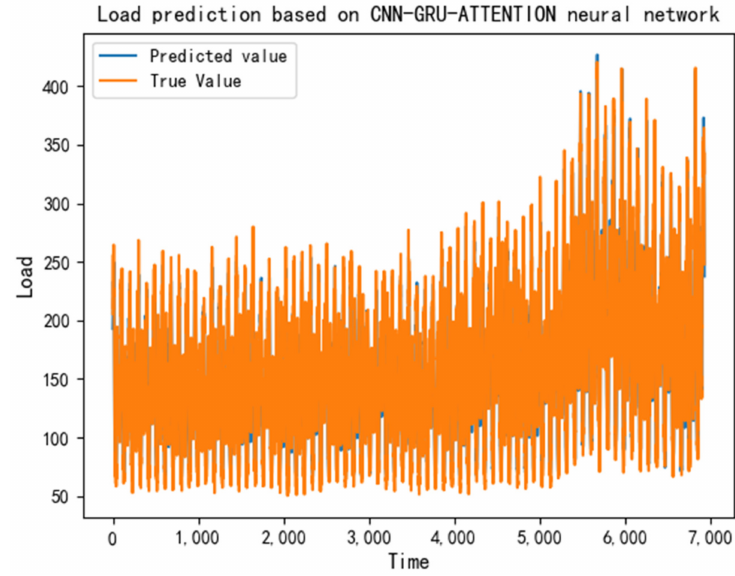
Figure 8. Real data predicted value vs. real